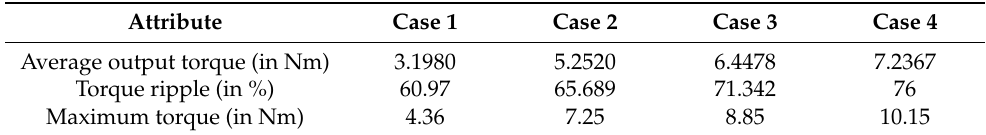
Table 3. Comparative performance analysis.